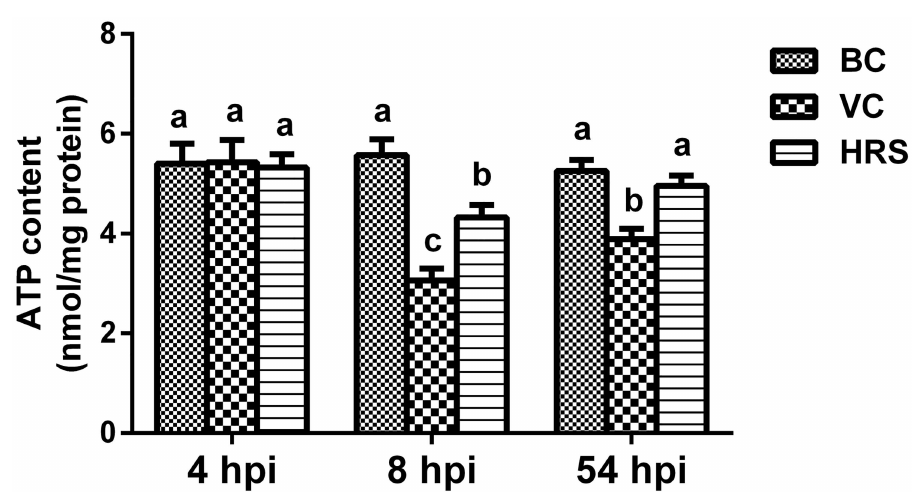
Fig 3. Changes of ATP content in liver tissue homogenate at 4 hpi, 8 hpi and 54 hpi (hpi: Hours Post- Injection). Liver tissue sampleswere obtainedfrom individualducklingsof each group at the indicatedtime points, and the ATP content in liver tissue was detected with ATP assay kit. a-c Bars in the same index at the same time point without the same superscripts differ significantly ( p < 0.05).